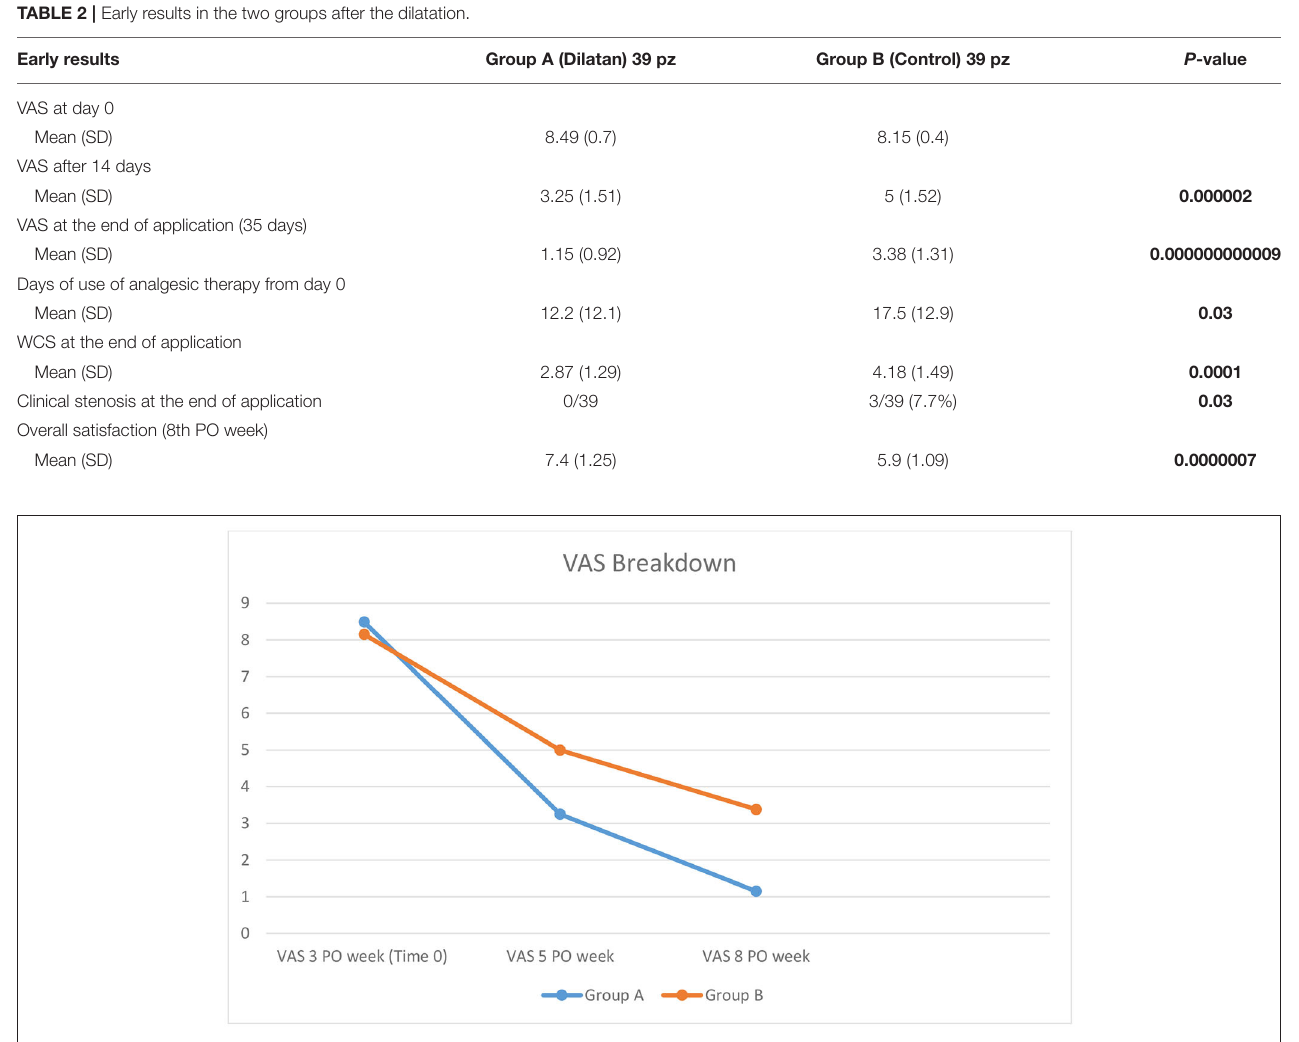
FIGURE 2 | Pain breakdown in the two Groups after the start of